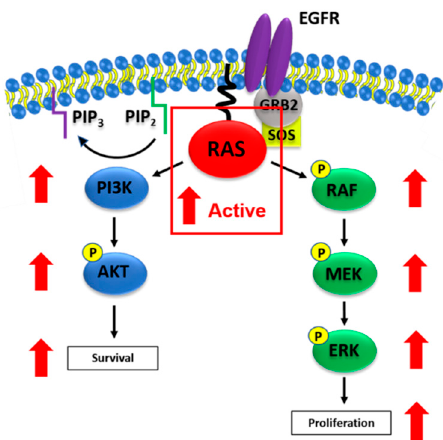
Figure 2. Oncogenic RAS activation of MAPK and PI3K/AKT signaling. Figure 2 illustrates oncogenic RAS-mediated activation of MAPK and PI3K/AKT signaling. Mutant RAS proteins are prevalent in their active, GTP-bound states in tumor cells, resulting in elevated activation of downstream signaling cascades. Active RAS interacts with the RAS binding domain (RBD) of RAF to activate MAPK signaling, which is typically associated with tumor cell proliferation. RAS can also interact with the RBD of PI3K in order to activate PI3K/AKT signaling and promote tumor cell survival. Red arrows indicate elevations of phosphorylated protein levels in the presence of mutant RAS (outlined in the red box).